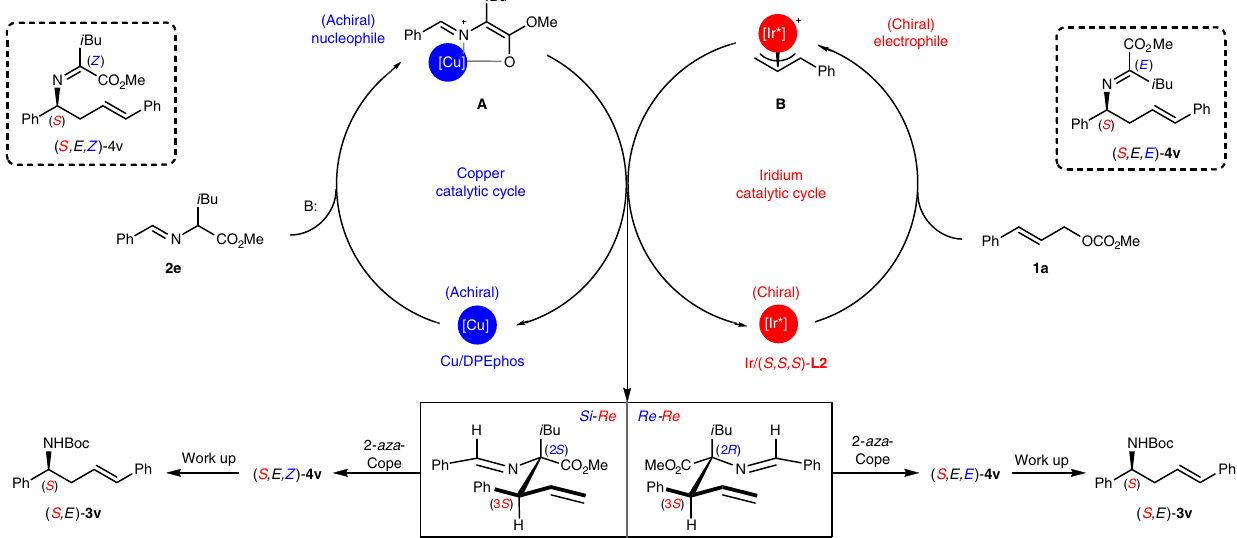
Fig. 8 Proposed catalytic cycles and reaction mechanism. Rationale on asymmetric cascade allylation/2- aza -cope rearrangement catalyzed by dual Cu/ DPEphos complex (achiral) and Ir/( S,S,S )- L2 complex